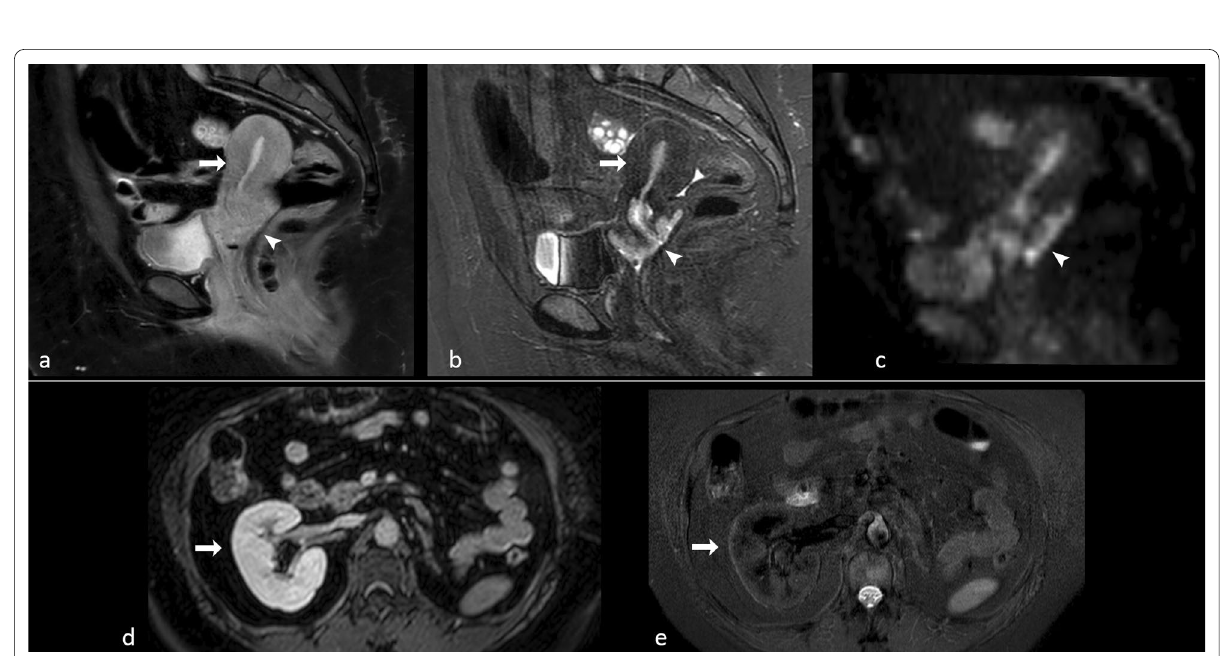
Fig. 14 38-year-old patient with cervical carcinoma. On contrast-enhanced turbo spin echo (TSE) T1-w. fat-saturated sagittal image ( a ) differentiation between normal uterus and cancer is difficult. On sagittal short inversion time inversion recovery (STIR) scan ( b ) obtained at the same level immediately after TSE sequence, the signal of normal uterus is cancelled and hyperintense cancer is well depicted. There is an optimal correspondence between STIR and diffusion-weighted image ( c ), where spatial resolution is however lower. Contrast-enhanced gradient echo (GE) T1-w. fat-saturated scan ( d ) through the right kidney. Contrast-enhanced fast-STIR image ( e ) obtained immediately after d shows that the signal of renal parenchyma is cancelled since its T1 is equal to that of